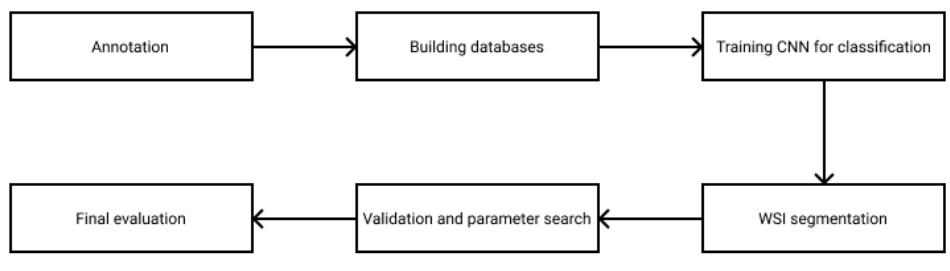
Figure 1. Flowchart of the research